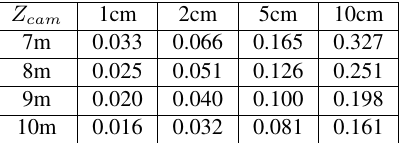
Table 2. Stereo parallax accuracy σ m in pixel (col. 2-4) to